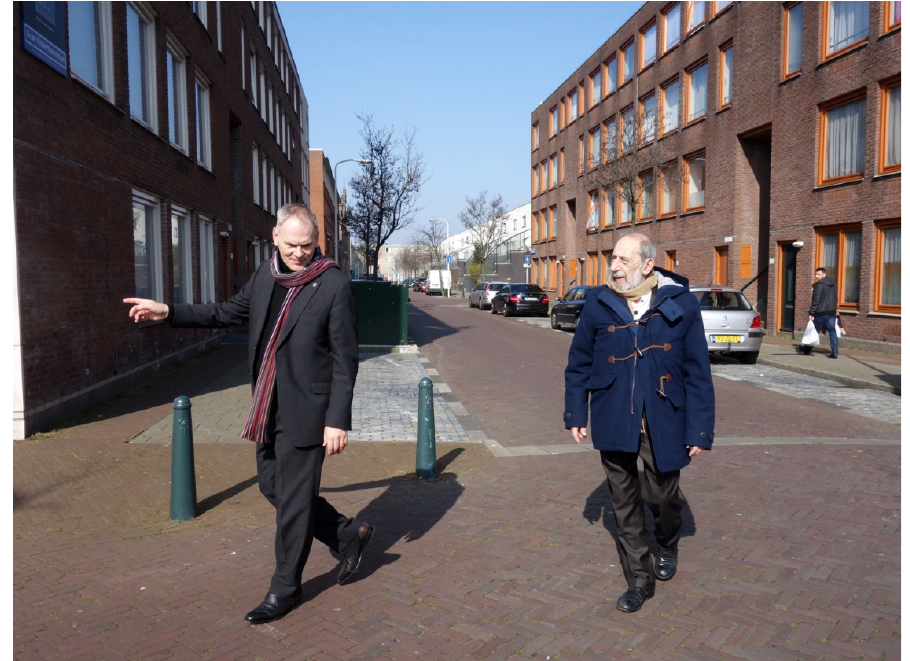
Figure 9. Álvaro Siza with Adri Duivenstijn visiting the Schilderswijk neighbourhood, The Hague. Photographed by the